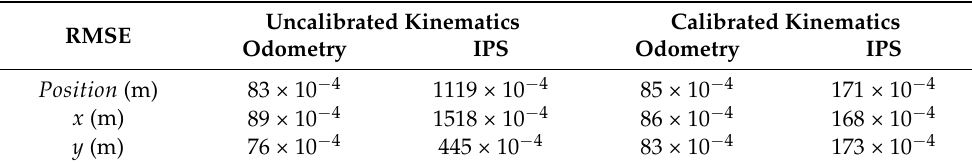
Table 4. Root-mean-squared trajectory tracking deviation. Uncalibrated Kinematics Calibrated Kinematics RMSE Odometry